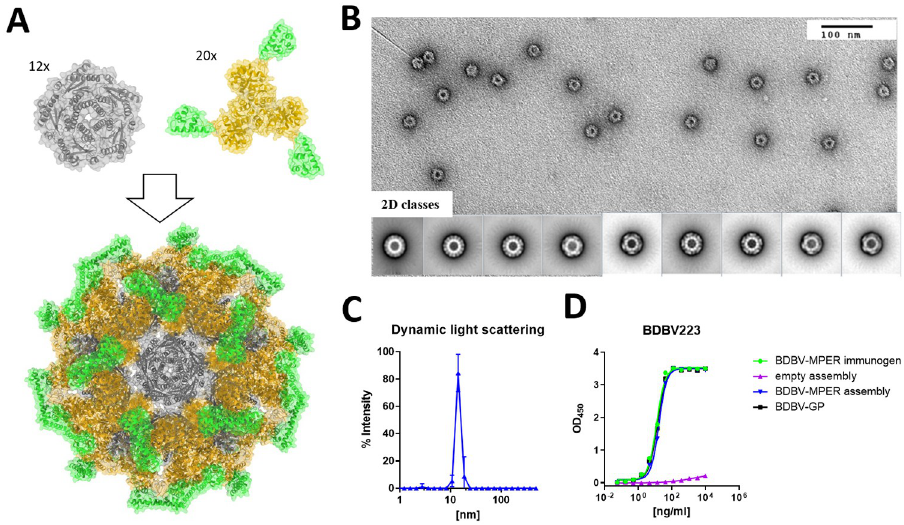
Fig 3. Design and characterization of self-assembling nanoparticles displaying the BDBV-MPER immunogen. (A) Model of the self-assembling nanoparticle displaying the BDBV-MPER immunogen on the trimeric component of the two-component I53-40 nanoparticle. (B) Negative stain electron microscopy 2D classes for I53-40 nanoparticles decorated with the BDBV-MPER immunogen. (C) Dynamic light scattering confirmed a homogeneous size distribution (n = 2, triplicates, exemplary experiment shown). (D) BDBV223 binding to the BDBV-MPER-bearing I53- 40 nanoparticle observed by ELISA (n = 2, duplicates, SD). BDBV223 did not show any binding to empty I53-40